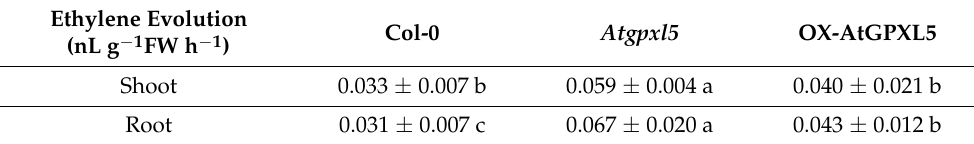
Table 2. Ethylene evolution in the shoots and roots of hydroponically grown 6-week-old Arabidopsis thaliana wild type (Col-0), Atgpxl5-1 insertional mutant ( Atgpxl5 ) and AtGPXL5-overexpressor (OX- AtGPXL5) plants. Mean ± SD, n = 5. Data were analysed using one-way ANOVA followed by Duncan’s test. Different letters represent data considered statistically significant at p ≤ 0.05.